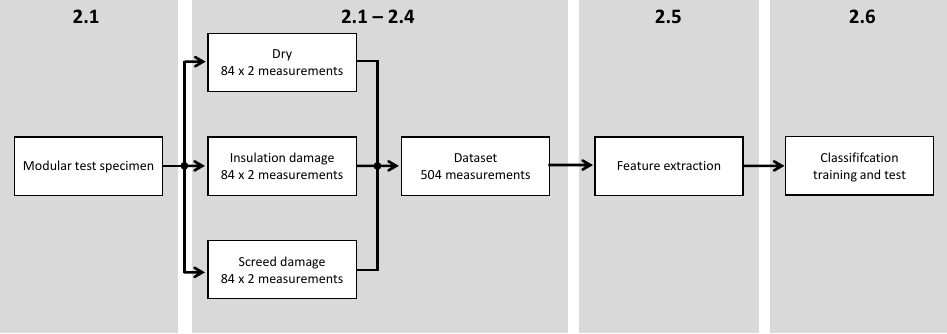
Figure 2. Schematic of the work steps presented in Section 2 divided by their respective